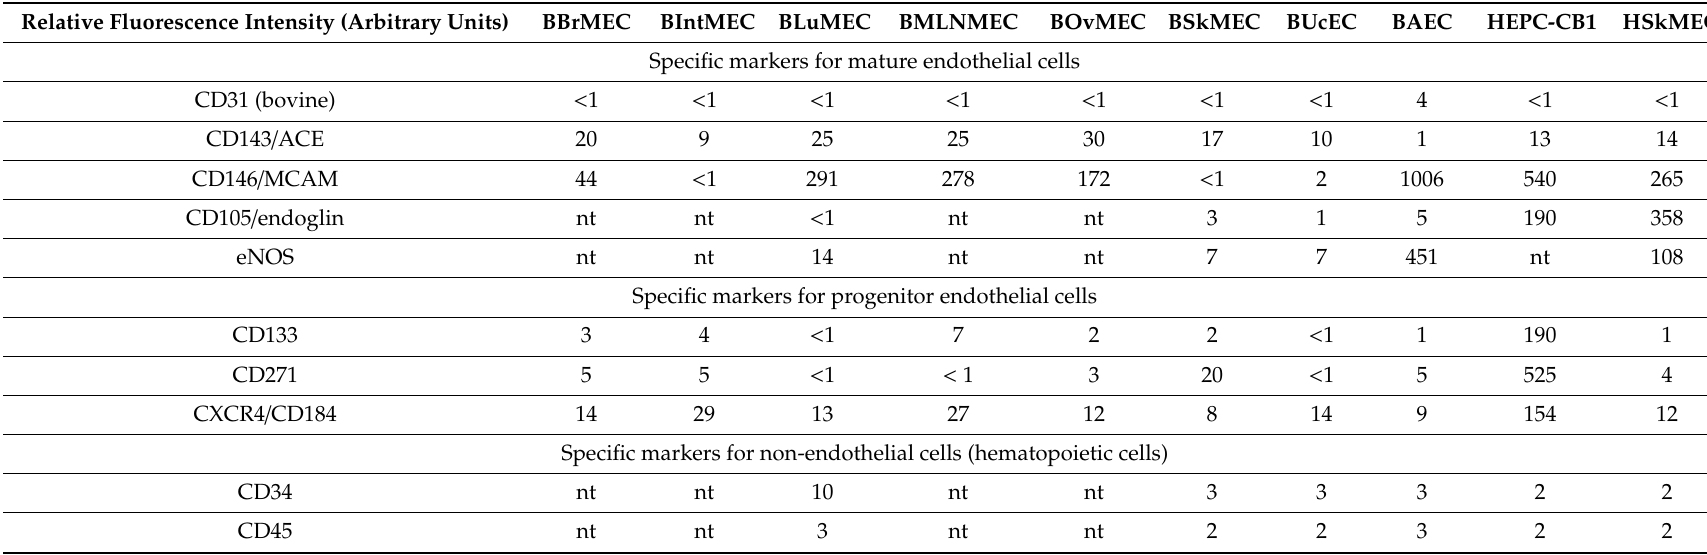
Table 3. Detection of specific cell markers in bovine endothelial cell lines by flow